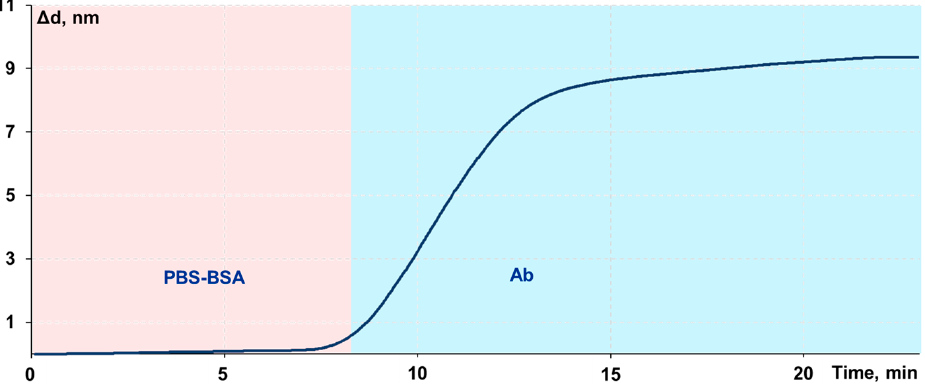
Figure 4. Sensorgram of FA antibody binding to a sensor chip with attached FA–gelatin conjugate (FA antibody concentration—70 µg/mL).